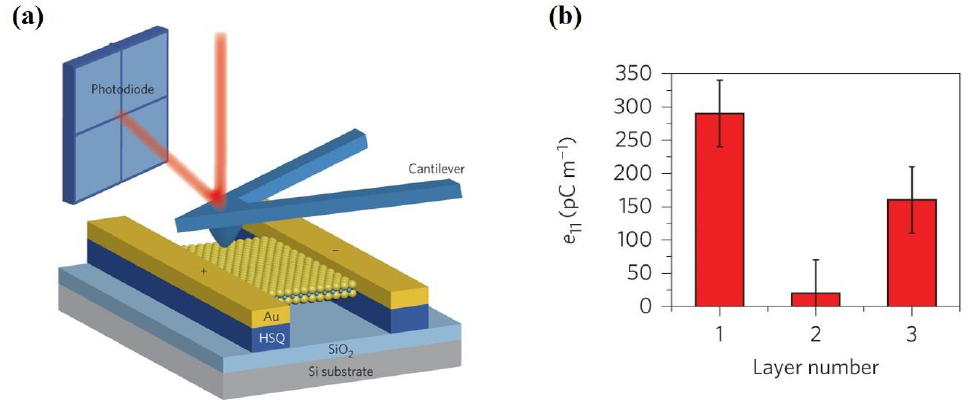
Figure 5. ( a ) The schematic diagram of a device for measuring the in-plane piezoelectric stress. Two hydrogen silsesquioxane (HSQ) columns are under the MoS 2 film, which are on a SiO 2 /Si substrate with an Au electrode on the upper side. The AFM probe changes the fold degree of the film and deflects the laser beam, so that the stress can be obtained through the load change on the cantilever beam [33]. Reproduced with permission from [33]. Copyright 2014, Springer Nature. ( b ) The measured piezoelectric response of MoS 2 is odd–even dependent as the number of layers increases [33]. Reproduced with permission from [33]. Copyright 2014, Springer Nature.